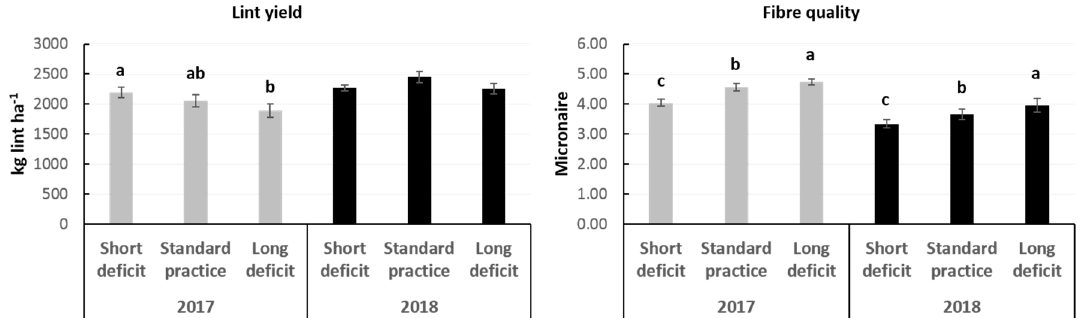
Figure 5. Average values of lint yield and fibre macronaire for each irrigation treatment during the 2016/17 and 2017/18 cotton growing seasons. Different letters between treatments within each season indicate statistically significant differences at p < 0.05. Vertical bars indicate the standard deviation for each treatment.